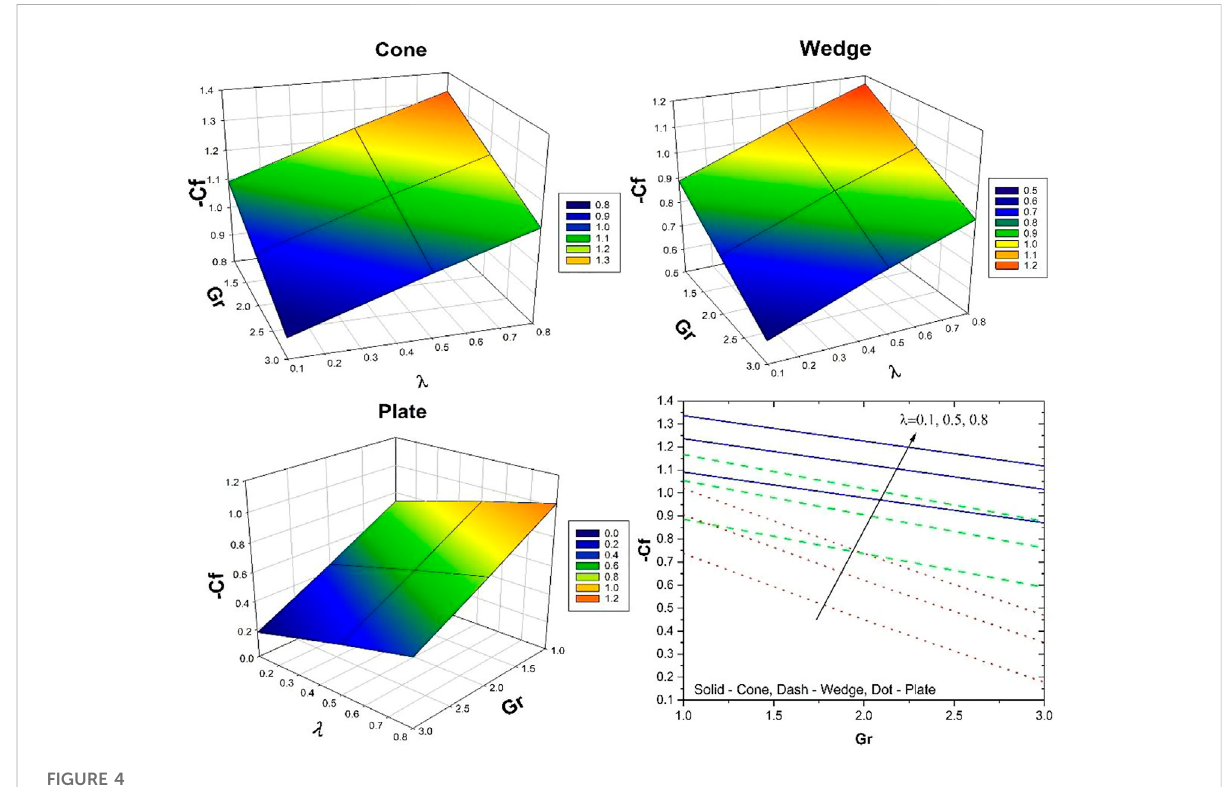
FIGURE 4 Behavior of − Cf over Gr for various values of λ